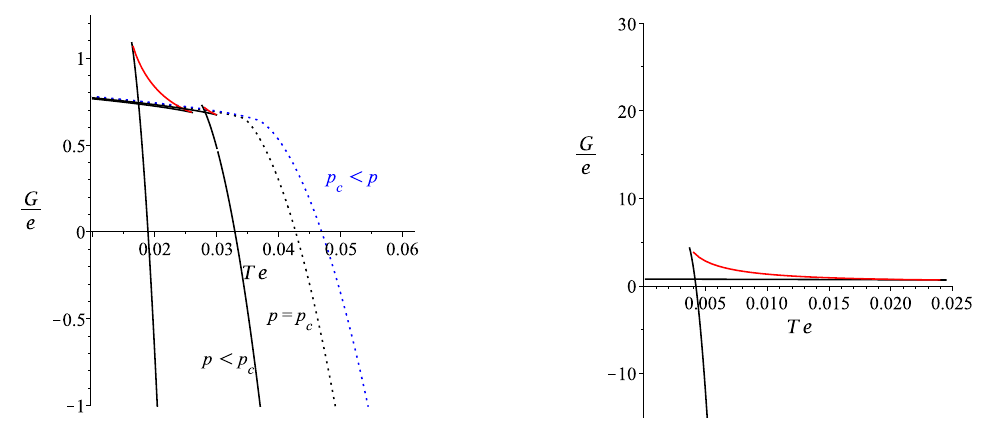
Figure 5 . Free energy (color online). We select e = 1, (cid:12) 3 = (cid:0) 4 e 4 and (cid:11) 4 = 5 e 6 ; physical conditions are ful(cid:12)lled with P c e 2 (cid:25) 0 : 00210. Left: a plot of the Gibbs free energy versus temperature for d = 4 and k = 1, for various values of the pressure: P = 1 : 2 P c (dotted, blue curve), for P = P c (dotted, black curve), for P = 0 : 6 P c and P = 0 : 2 P c (solid black and red lines). Right: plot for P = 0 : 01 P c . In each plot, the red lines indicate the parts of the curves for which the speci(cid:12)c heat is negative; quantities are rescaled by appropriate values of the electric charge e to obtain dimensionless